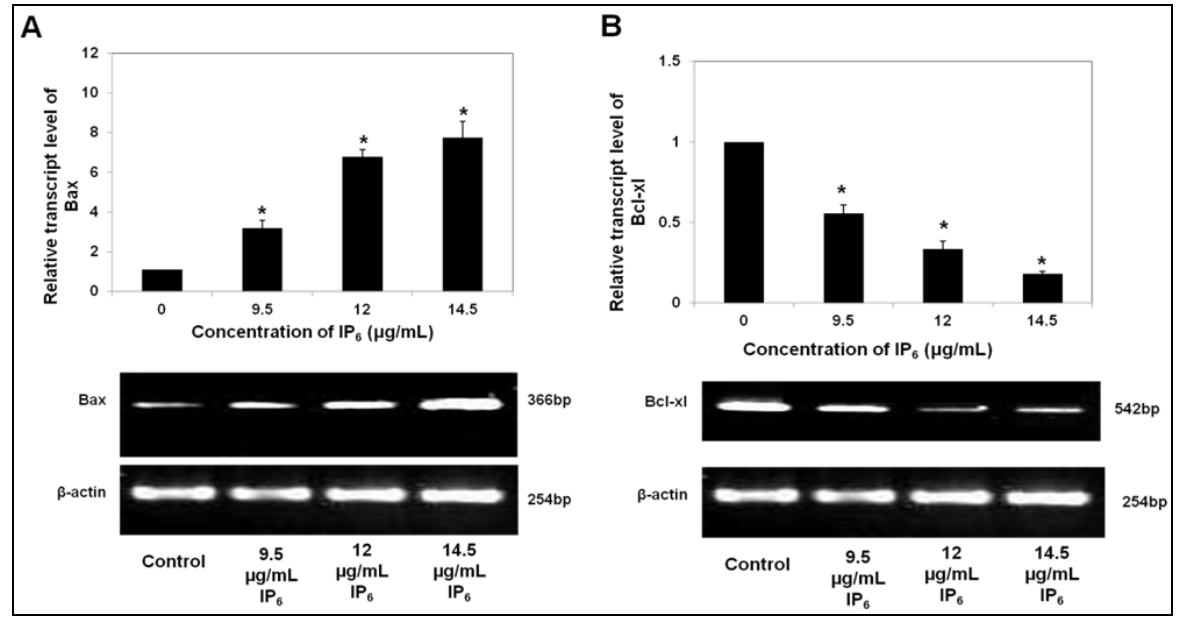
Figure 1. Expression of apoptotic related genes at mRNA level in HT-29 cells incubated with IP . ( A ) Upregulation of pro-apoptotic, Bax ; and ( B ) Downregulation of anti-apoptotic, 6 Bcl-xl in a dose-dependent manner. HT-29 cells were incubated with IP 14.5 µg/mL) for 72 h at 37 °C. Results are from 3 independent experiments and presented as the mean ± SD. * indicate significant difference by Tukey’s test ( p < 0.05) relative to their respective